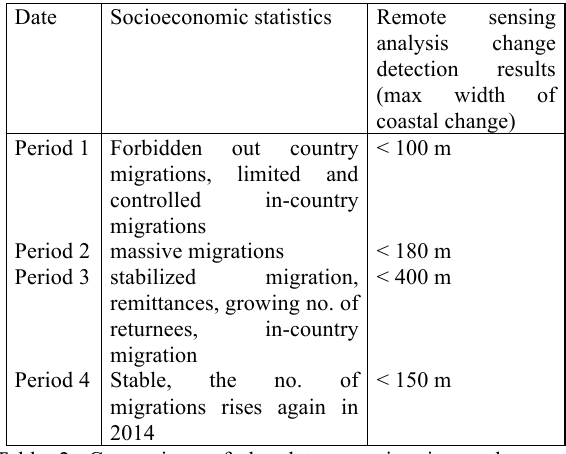
Table 2. Comparison of the data on migration and remote sensing change detection